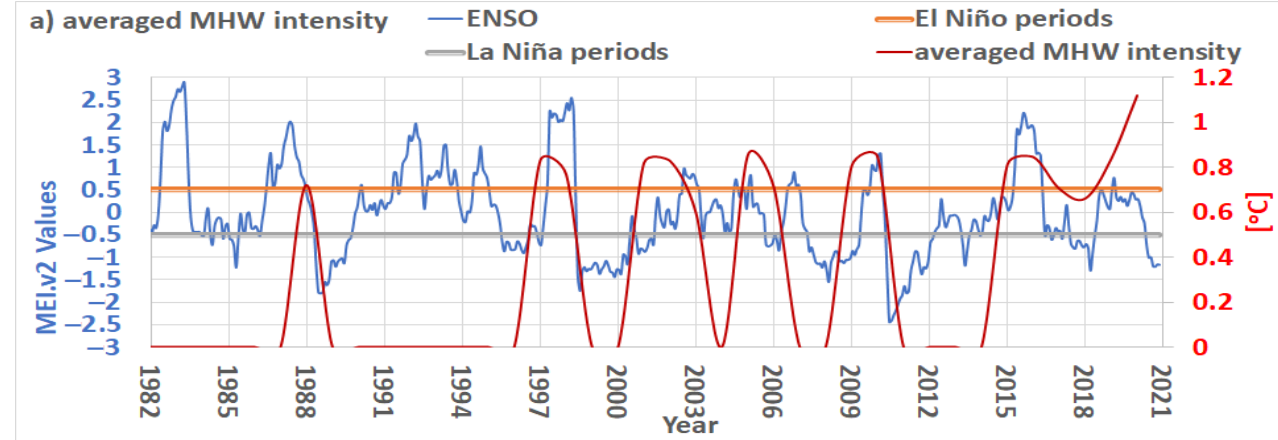
(La Niña periods) periods, except during 1983 (years of the El Niño event), which correlated higher MHWs duration value. Similarly, the MHWs frequency tends to increase (decrease) during El Niño (La Niña periods) periods, except during 1983 and 2015.